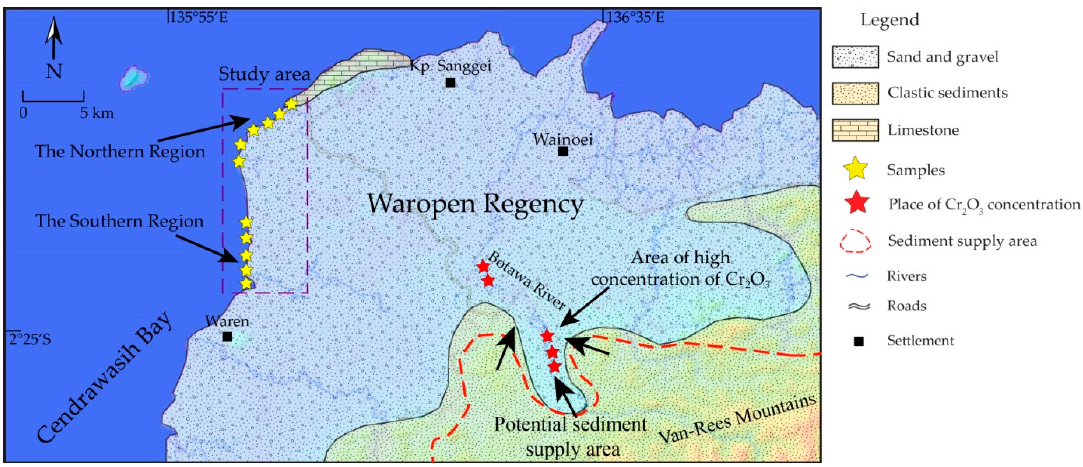
Figure 2. Geology map of the Waropen Regency [33–35].